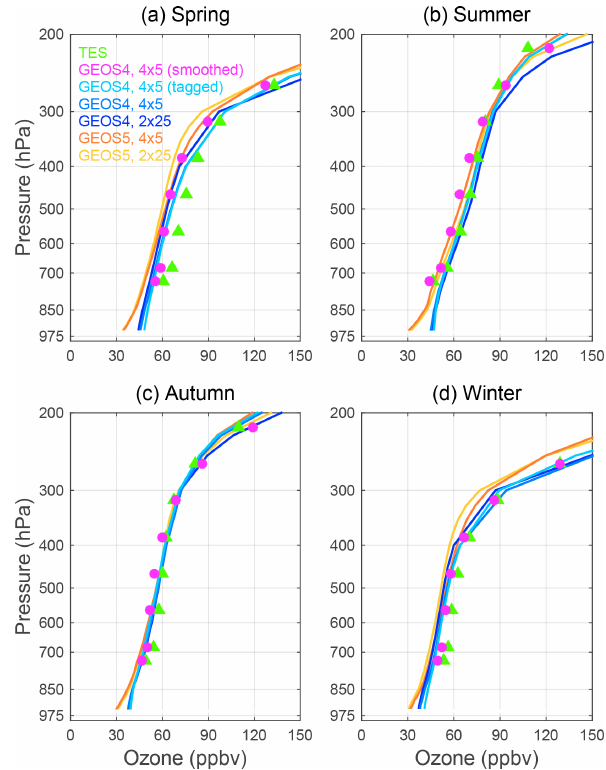
Figure 2. Vertical ozone profiles averaged over East Asia in 2005 from GEOS-Chem simulations driven by GEOS-4 and GEOS-5 me- teorological data with different horizontal resolutions (4 ◦ by 5 ◦ and 2 ◦ by 2.5 ◦ in latitude and longitude). TES retrievals (in green) and GEOS-Chem simulations smoothed with the TES a priori and aver- aging kernels (in magenta) are also